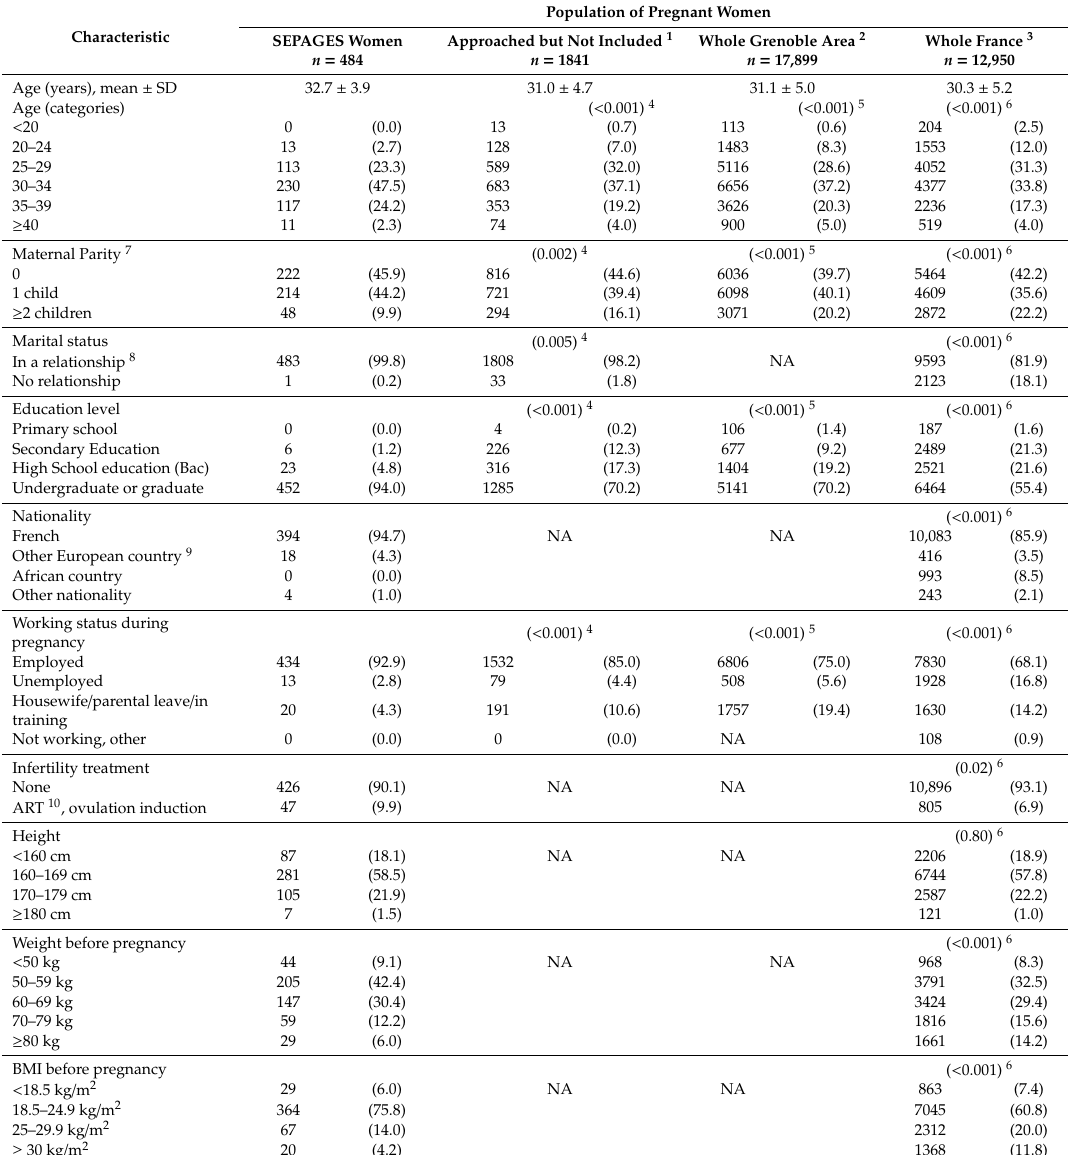
Table 1. Description of SEPAGES cohort women and comparison with samples of pregnant women from Grenoble and